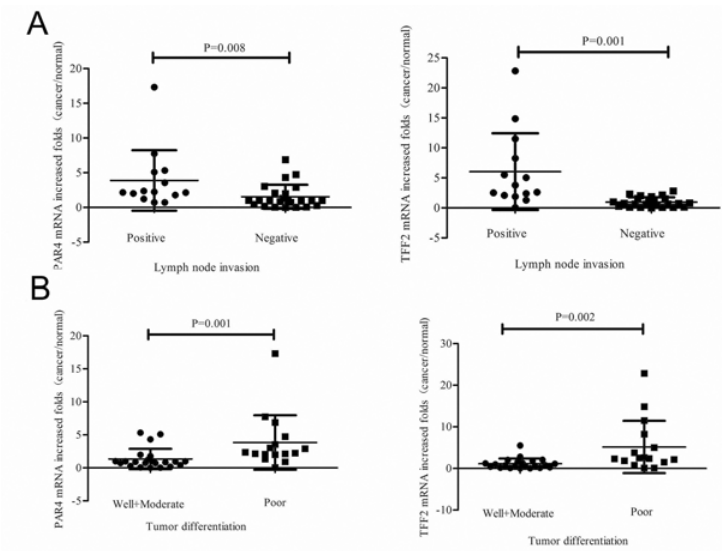
Fig 2. Expression of PAR4 and TFF2 mRNA in colorectal cancers and non-neoplastic tissues. Expression of PAR4 and TFF2 was measured in 38 colorectal cancer patients by real-time PCR. (A) PAR4 mRNA was increased in 86% (12 of 14) lymph node invasive tumors and 42% (10 of 24) non-invasive tumors. TFF2 mRNA was increased in 93% (13 of 14) lymph node invasive tumors and 38% (9 of 24) non-invasive tumors. There was significant difference of PAR4 (p = 0.008) and TFF2 (p = 0.001) mRNA expression between lymph node invasive tumors and non-invasive tumors; (B) PAR4 mRNA was increased in 88% (14 of 16) poor-differentiated cancers and 36% (8 of 22) well-/moderated-differentiated cancers. TFF2 mRNA was increased in 81% (13 of 16) poor-differentiated cancers and 46% (9 of 22) well-/moderated-differentiated cancers. Also, there is a significant difference of PAR4 (p = 0.001) and TFF2 (p = 0.002) mRNA expression between poor-differentiated and well-/moderated-differentiated cancers; Mean fold increase in the tumor tissue in relative to non-neoplastic colorectal tissue was shown. Median (quartile 25, quartile 75) was used to compare folds of PAR4 (TFF2) increase in lymph node invasive tumors and non-invasive tumors, and poor- differentiated cancers and well-/moderated-differentiated cancers. The increased folds of “ > 1 ” were defined as “ increased ” , whereas increased folds of “ (cid:3) 1 ” were defined as “ not increased ” .